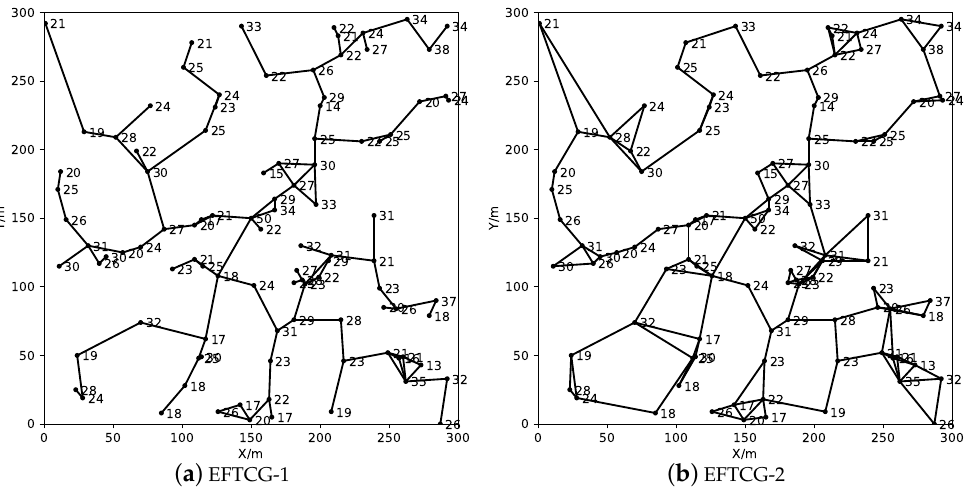
Figure 10. Topologies under different connectivity, ( a ) a topology derived under EFTCG-1; ( b ) a topology derived under